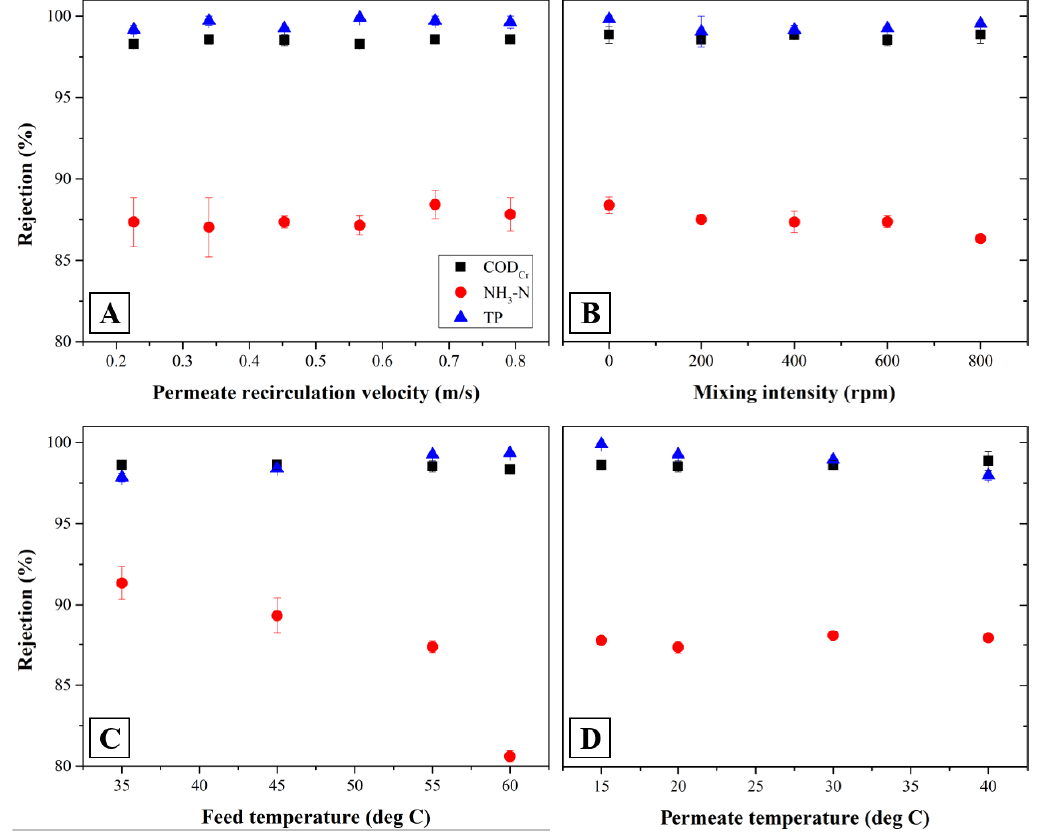
Figure 4. Rejection efficiency of COD Cr , NH 3 -N and T-P with operational parameters of SDCMD process after 1 h of operational time with respect to permeate recirculation velocity (A), mixing intensity (B), feed temperature (C) and permeate temperature (D) (background operational condition; permeate recirculation velocity of 0.5 m/s, mixing intensity of 600 rpm, feed temperature of 55 °C and permeate temperature of 20 °C).